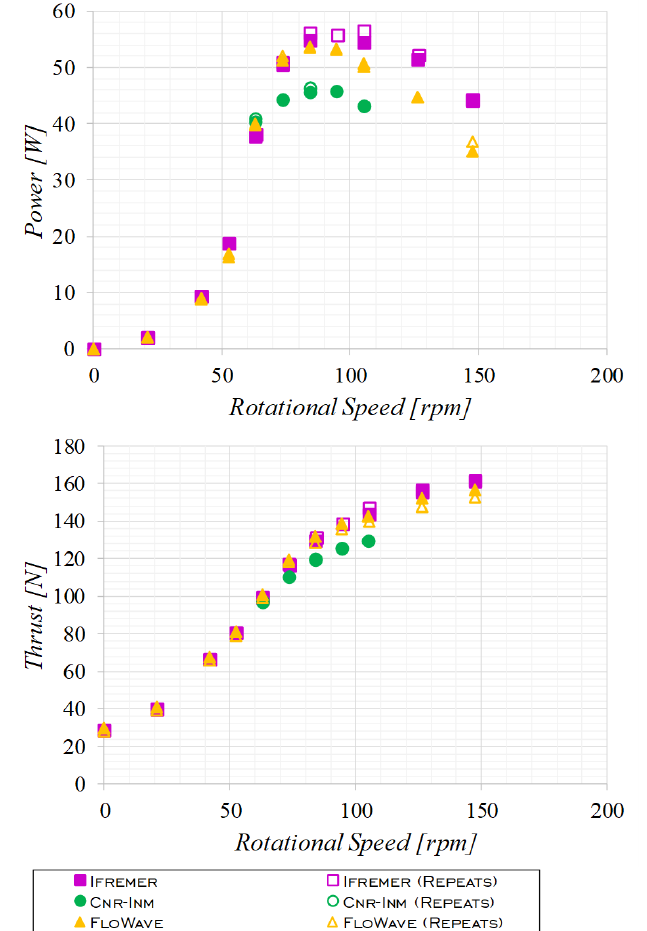
Figure 15. Case 2: Variation of the time average of the power ( top ) and thrust ( bottom ) measurements against turbine rotational speed for cases at 0.8 m/s, taken at each of the facilities with the repeated tests when